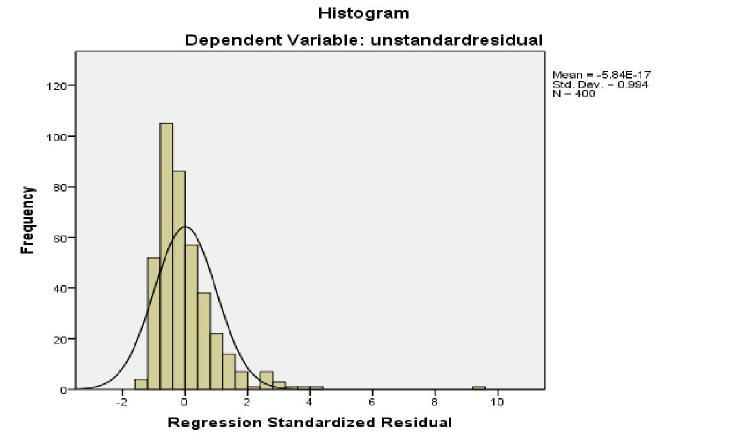
Fig. 1. The summary of